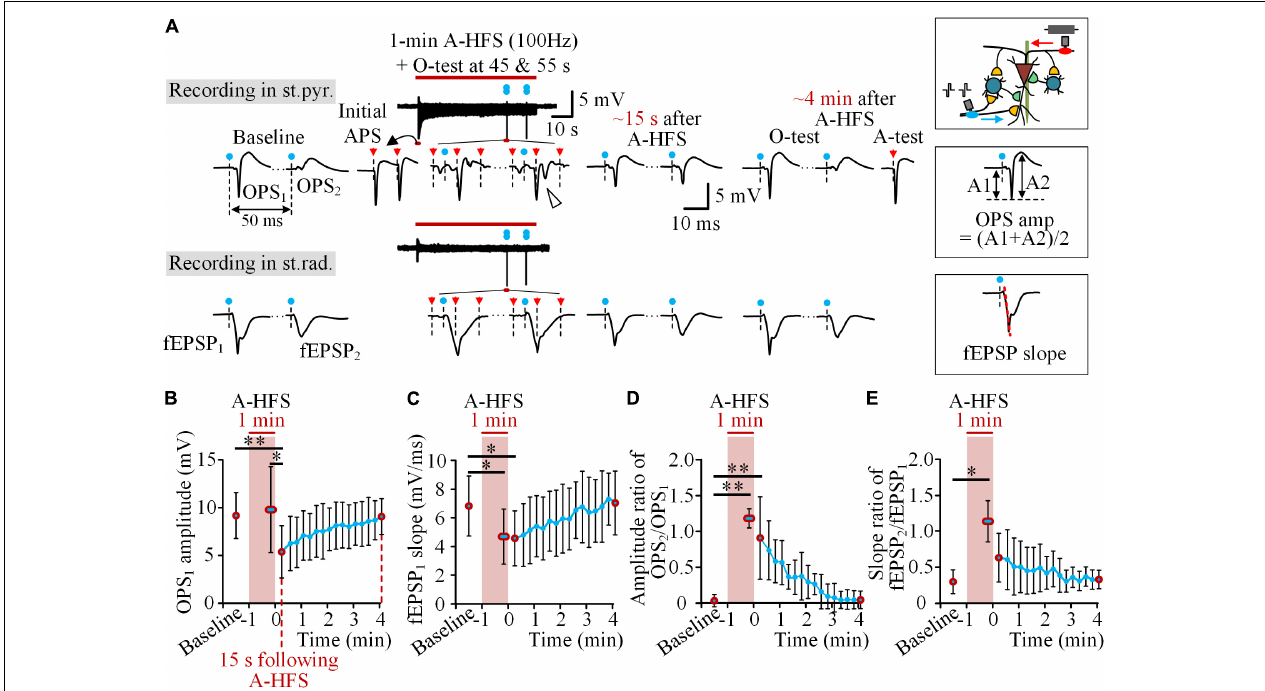
FIGURE 3 | Decrease of the excitability of pyramidal cells following A-HFS. (A) Typical examples of OPS and fEPSP waveforms evoked by the O-test paired pulses before, during, and after 1-min 100 Hz A-HFS. During A-HFS, the O-tests were applied at 45 and 55 s of A-HFS. After A-HFS, the O-tests were applied every 15 s till ∼ 4 min after the end of A-HFS. The blue dots denote the artifacts of O-test paired pulses and the red arrows denote the artifacts of A-HFS pulses. A schematic diagram of stimulations and recordings is shown on the upper-right corner. The measurements of OPS amplitude and fEPSP slope are illustrated on the middle-right and bottom-right, respectively. (B–E) Changes of OPS 1 amplitude (B) , fEPSP 1 slope (C) , amplitude ratio of OPS 2 /OPS 1 (D) , and slope ratio of fEPSP 2 /fEPSP 1 (E) before (baseline), during, and after the 1-min 100 Hz A-HFS. Red circles denote the data of baseline, the average of two O-tests in late A-HFS, the data at 15 s following A-HFS, and the recovered data at ∼ 4 min after A-HFS. ∗ P < 0.05, ∗∗ P < 0.01, repeated one-way ANOVA with post hoc Bonferroni tests, n = 8